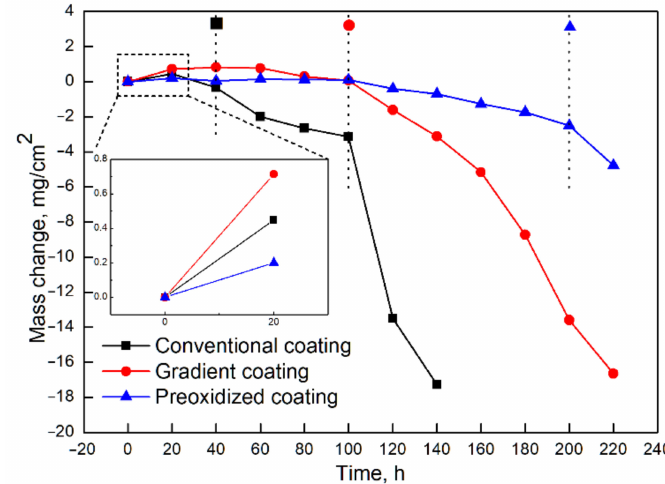
Figure 5. Corrosion kinetic curves of the conventional, gradient and preoxidised coatings in the cyclic hot corrosion test at 900 ◦